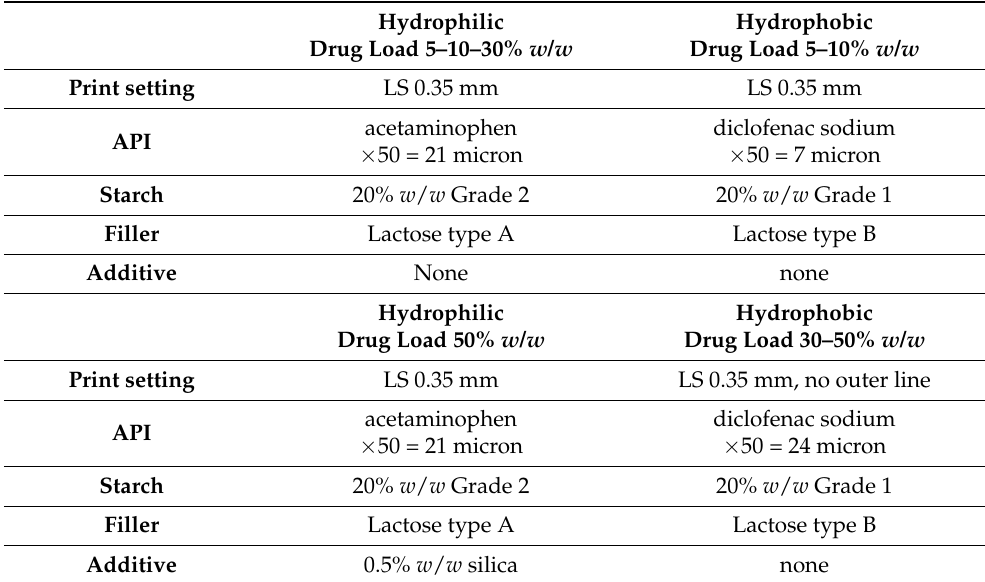
Table 4. Platform formulation and print settings used for the clinical trial set-up formulations. Lactose monohydrate type A is a sieved grade with an × 50 of 75–85 µ m and lactose monohydrate type B is a milled and classified lactose with an × 50 of 80–90 µ m. Lactose grades were selected based on previous research